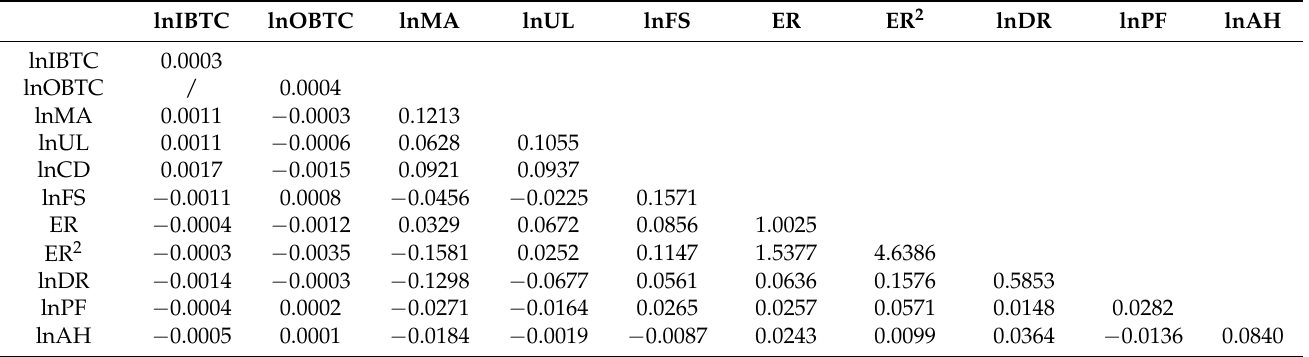
Table 8. Coefficient covariance matrix.